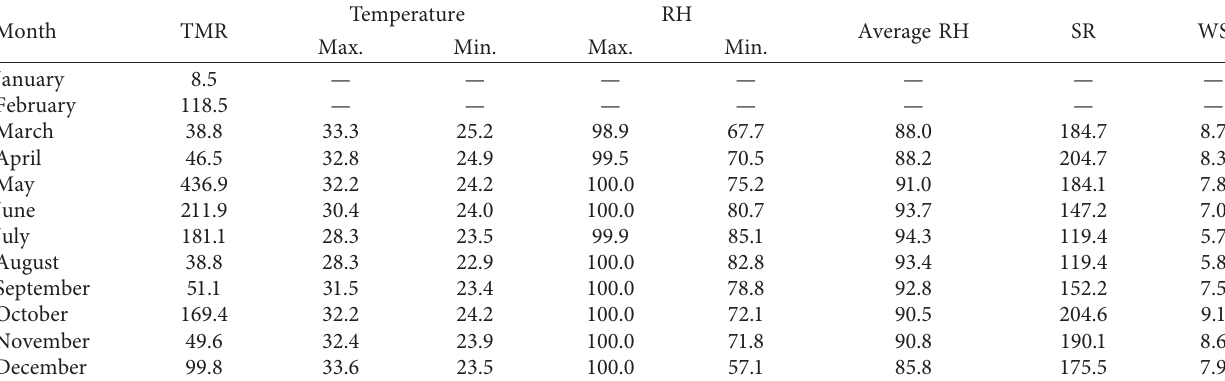
Average RH SR WS